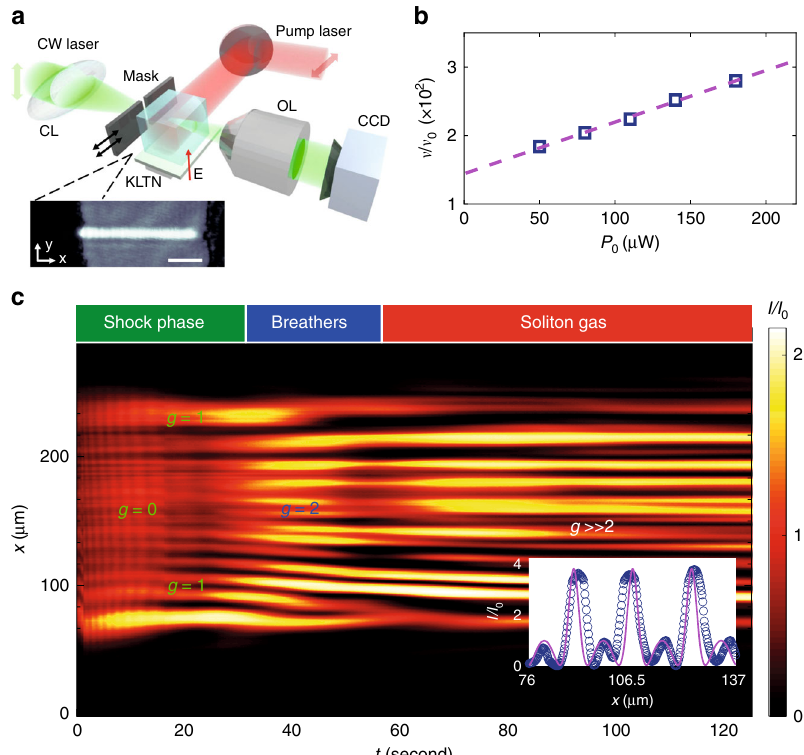
Fig. 3 Experimental demonstration of the extreme wave genus control. a Experimental setup. A CW laser is made a quasi-one-dimensional wave by a cylindrical lens (CL), then a tunable mask shapes it as a box. Light propagates in a pumped photorefractive KLTN crystal, it is collected by a microscope objective and the optical intensity is detected by a CCD camera. The inset shows an example of the detected input intensity distribution (scale bar is 50 μ m). b Normalized shock velocity [ v 0 ¼ L = (cid:2) t , L ¼ 2 : 5 mm, (cid:2) t ¼ ð 30 ± 2 Þ s], measured through the width of the oscillation tail at fi xed time, versus input power. The blue squares are the experimental data, while the dashed pink line is the linear fi t. c Experimental observation of optical intensity I = I 0 for an initial beam waist W 0 ¼ 140 μ m. Axis x represents the beam pro fi le, transverse to propagation, collected by the CCD camera, while axis t is time of CCD camera detection. Output presents a fi rst dispersive-shock-wave phase, a transition to a phase presenting Akhmediev breather structures and, at long times, a generation of a soliton gas. The inset is an exemplary wave intensity pro fi le detected at t ¼ 63 s (dotted blue line), along with the